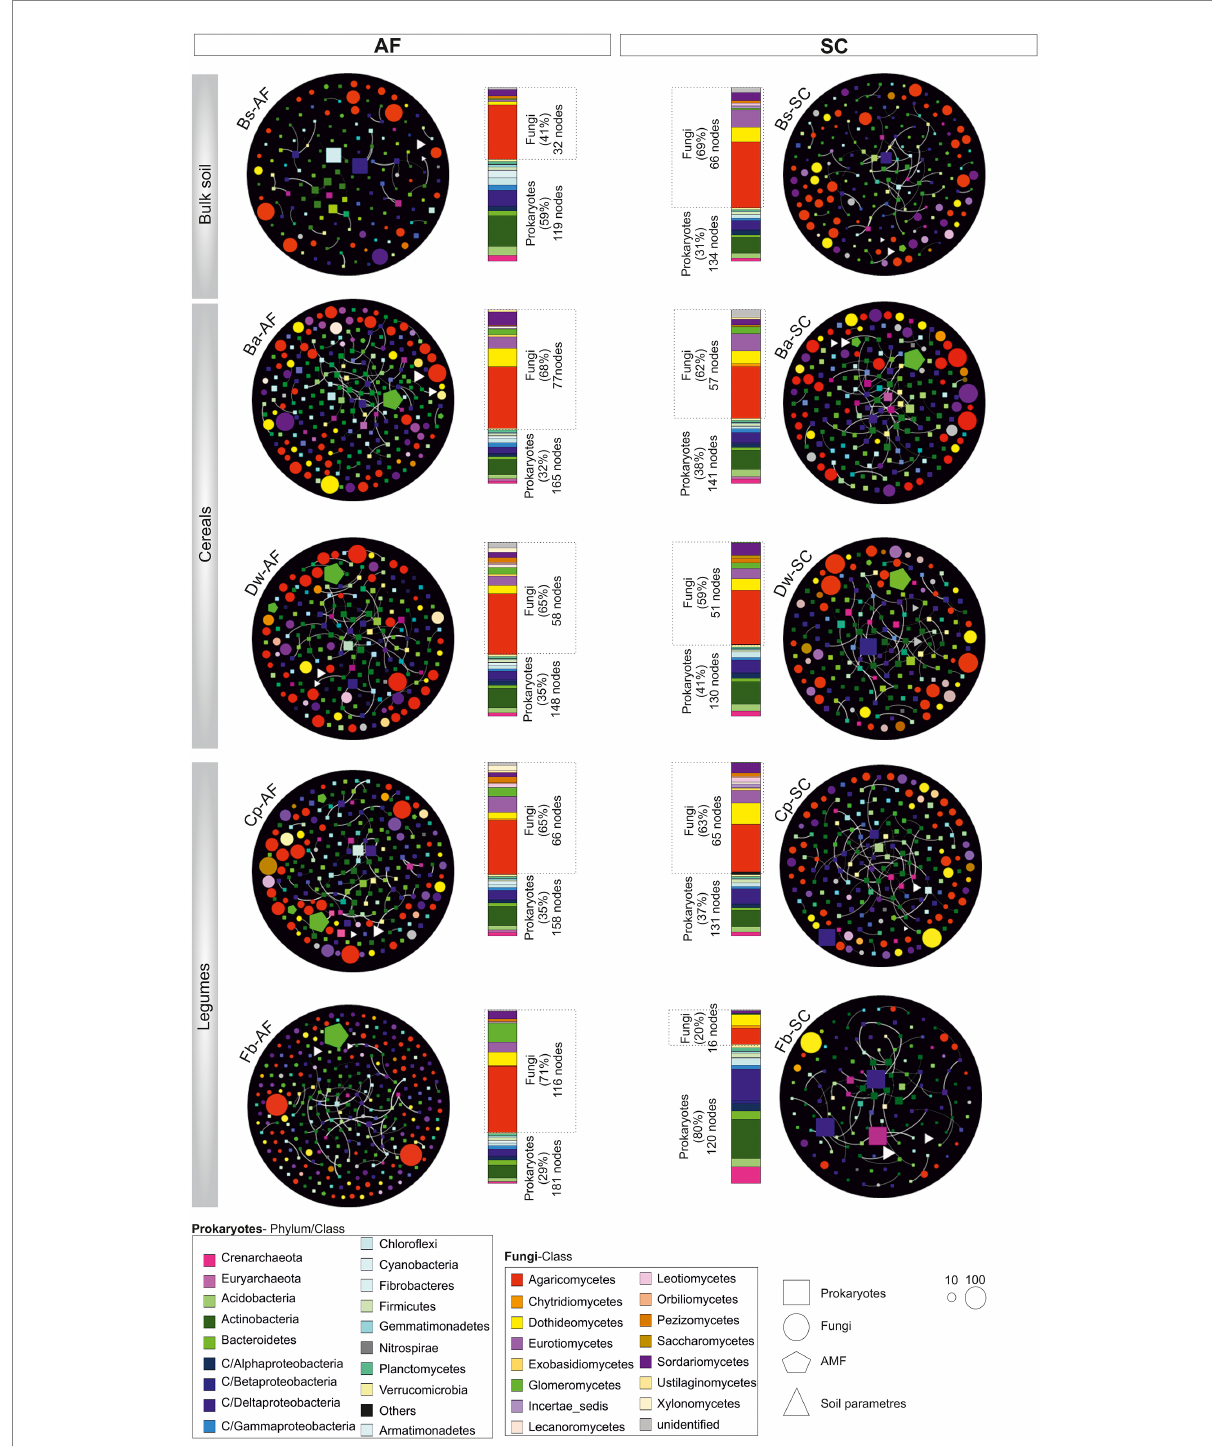
FIGURE 6 Network topology plots of the core microbial communities associated with root systems of cereals and legumes crops in an agroforestry system (AF) and full sun cropping (SC) samples. The nodes of each network are colored based on phylum or class affiliation (99%) and sized based on the degree of connection. For each microbiome species type, specific geometric shapes have been chosen (square, procaryotes; circle, fungi; AMF, pentagon), and the triangle shape has been selected for physiochemical soil parameters. White lines represent the thickness of the edge connecting the nodes. Relative abundance of those nodes with degree of connection is reported at the phylum/class level in the bar chart for each sample. Bs, bulk soil; Ba, barley; Dw, durum wheat; Cp, chickpea; Fb, Faba